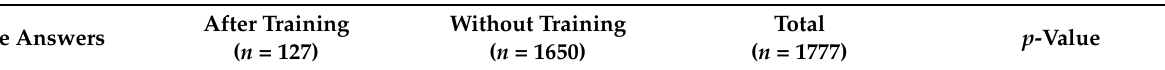
Table 4. Essential factors to implement vaccination services in pharmacies, indicated by the pharmacists participating and not participating in the Pharmacists Without Borders